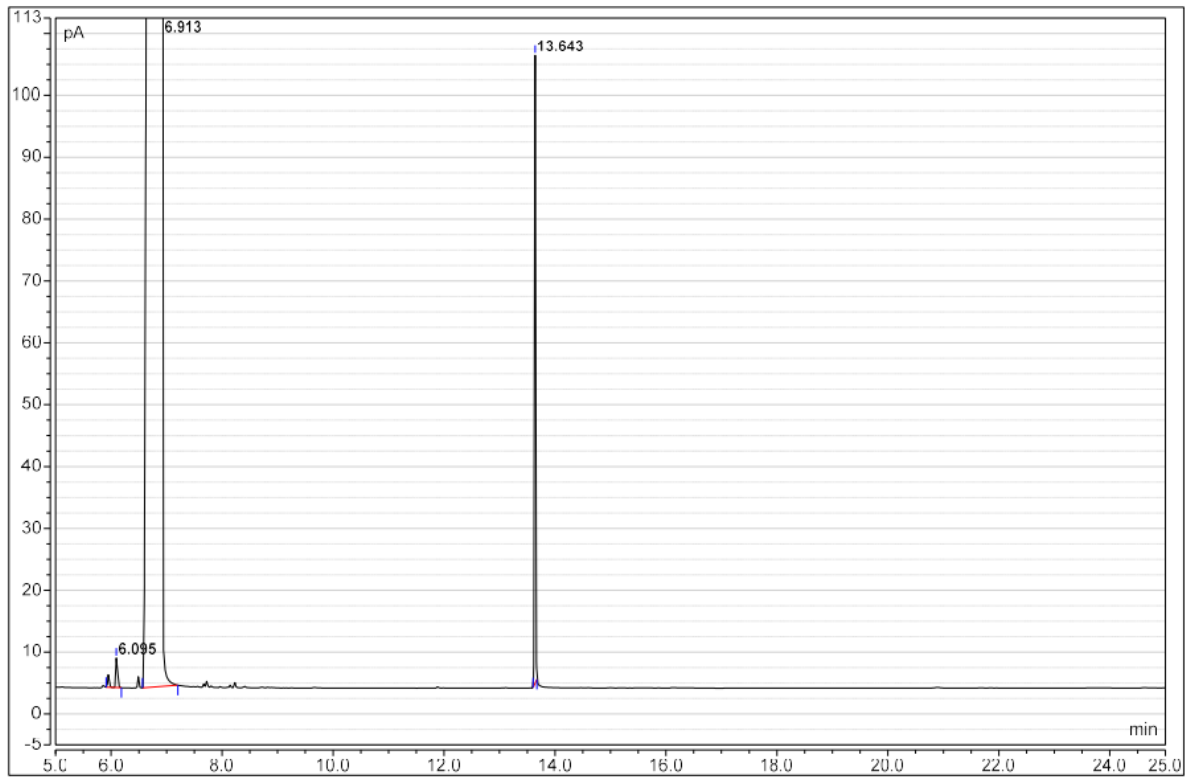
Figure 1. Gas chromatography of the crude mixture of the decarboxylation step (Table 2, entry 11). Propofol: t R = 13.643 min, in the presence of the 2-butoxyethanol ( t R = 6.095 and 6.913 min).